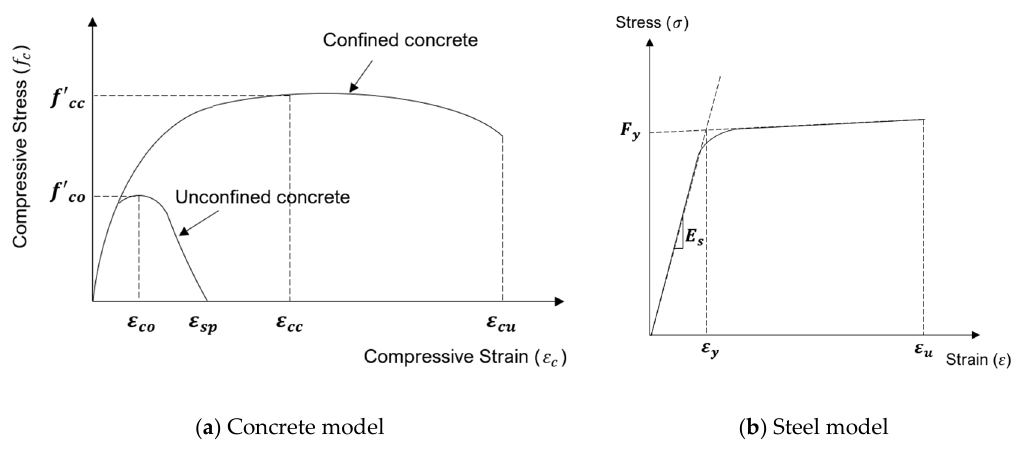
Figure 6. Stress–strain curves for the inelastic material model: ( a ) Mander et al. (1988) model; ( b ) Menegotto and Pinto (1973) model.